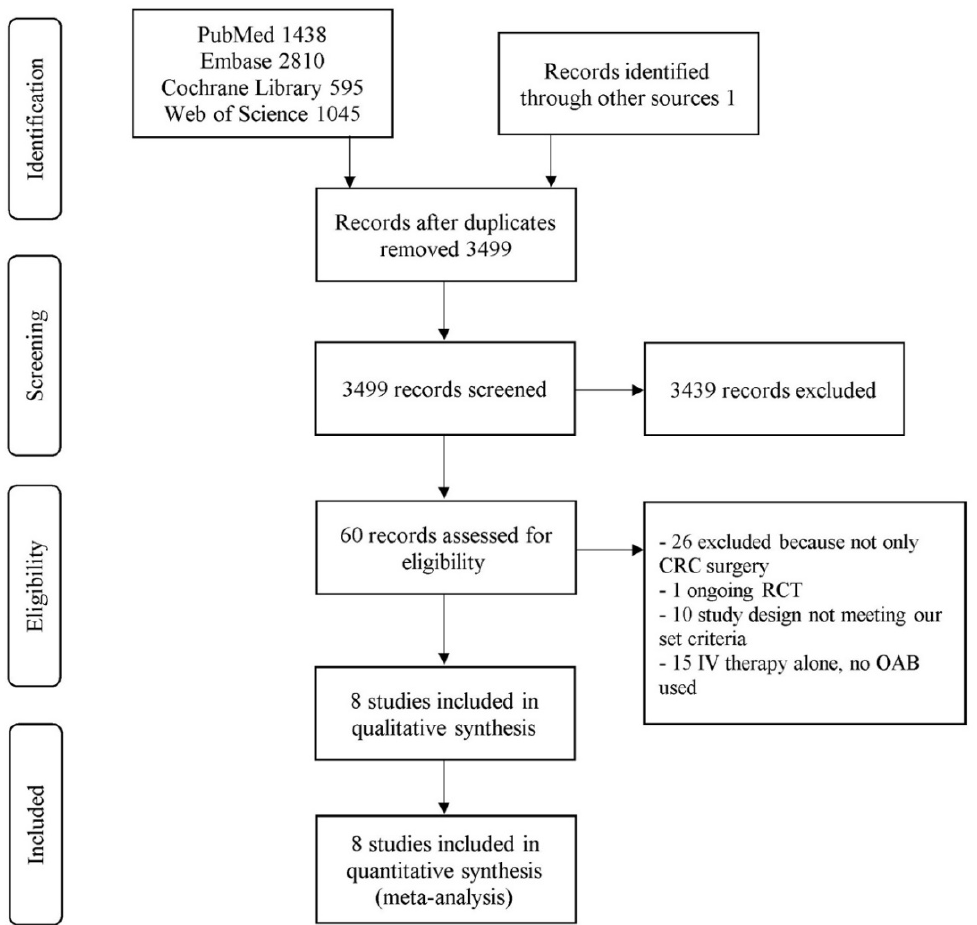
Figure 1. PRISMA diagram showing identification of studies from the initial literature search.